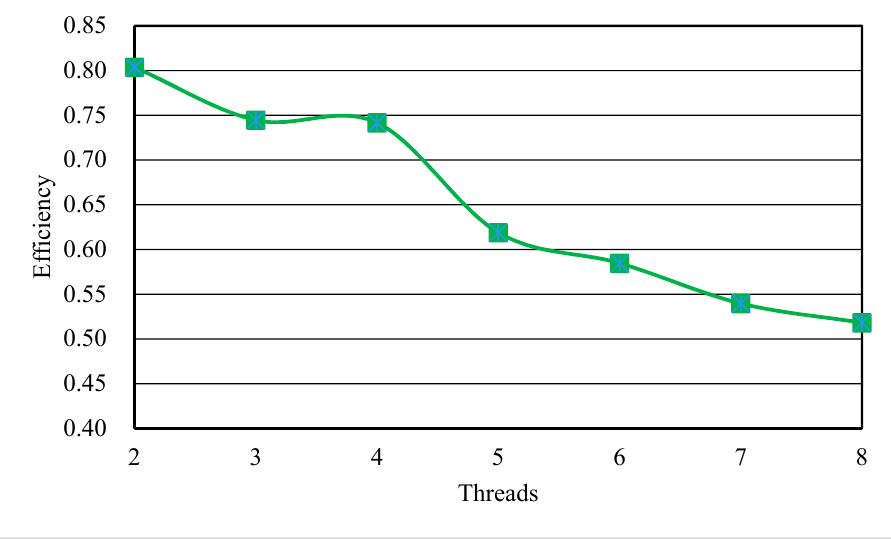
Figure 5. The efficiency with different number of threads.